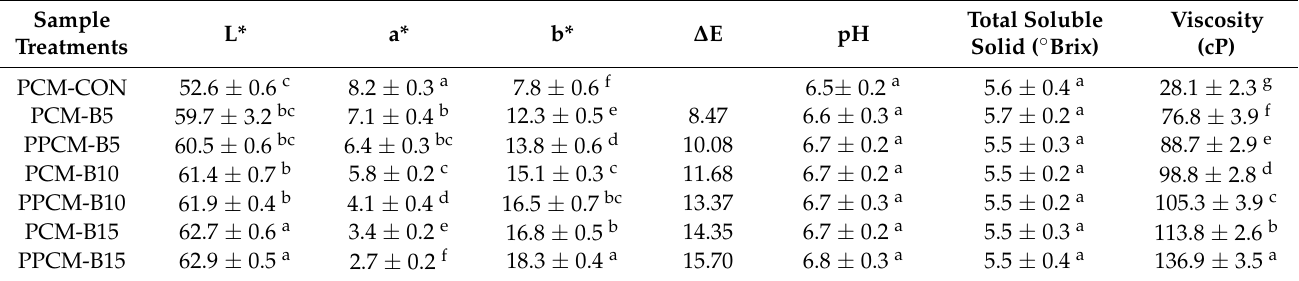
Table 1. Physicochemical properties of unpasteurized and pasteurized purple corn milk extracted from boiled purple corn kernels.